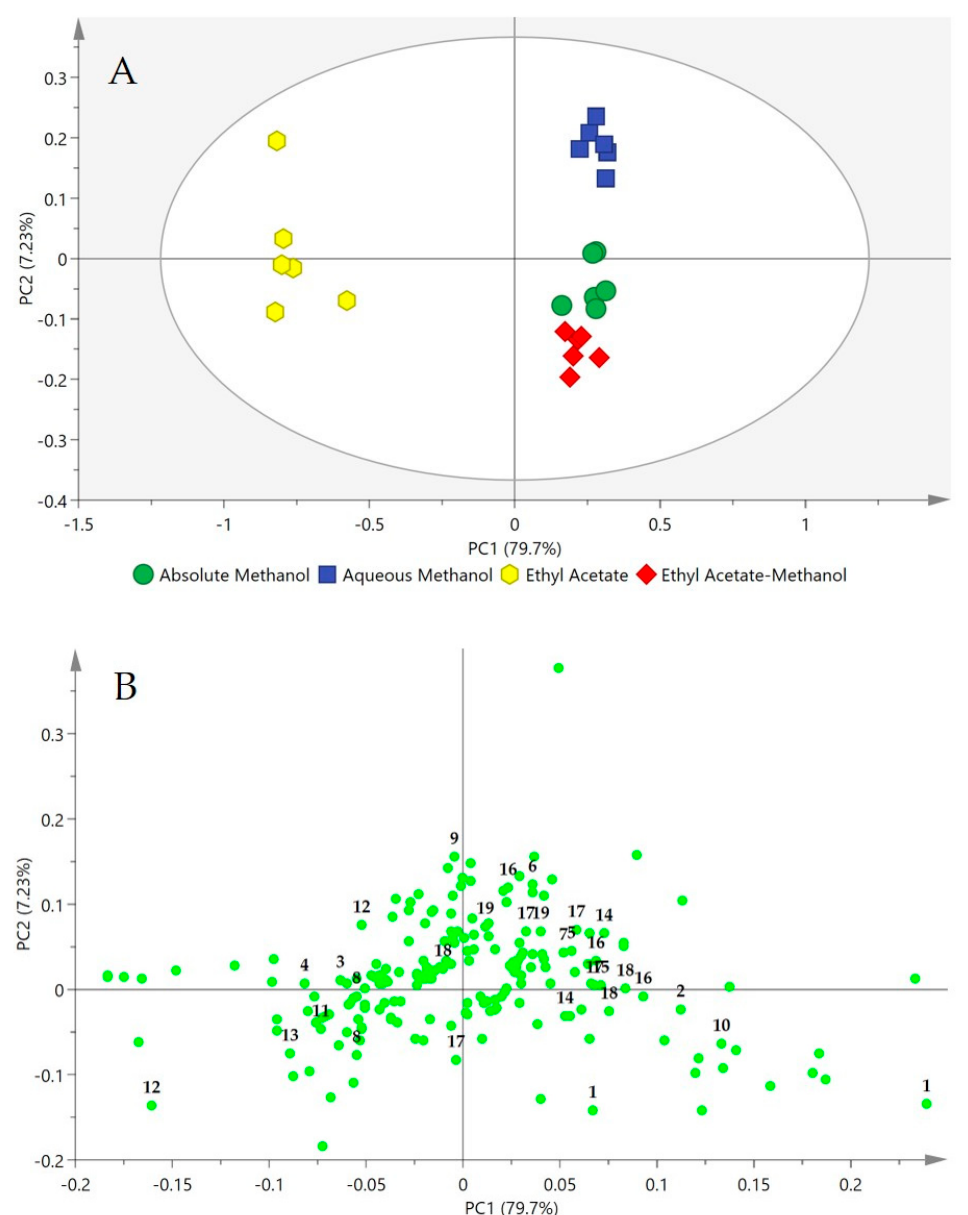
Figure 3. Principal component analysis (PCA) score ( A ) and loading ( B ) plots constructed from 1 H-NMR spectral data of four different solvent extracts of OPL. The plot ellipse represents 95% hoteling T2 confidence. Identified metabolites: 1 , sucrose; 2 , fructose; 3 , α -glucose; 4 , β -glucose; 5 , choline; 6 , citric acid; 7 , fumaric acid; 8 , palmitic acid; 9 , succinic acid; 10 , aconitic acid; 11 , fatty acid; 12 , α -linolenic acid; 13 , acetic acid; 14 , ( − )-epicatechin; 15 , ( + )-catechin; 16 , orientin; 17 , isoorientin; 18 , vitexin; 19 , isovitexin.